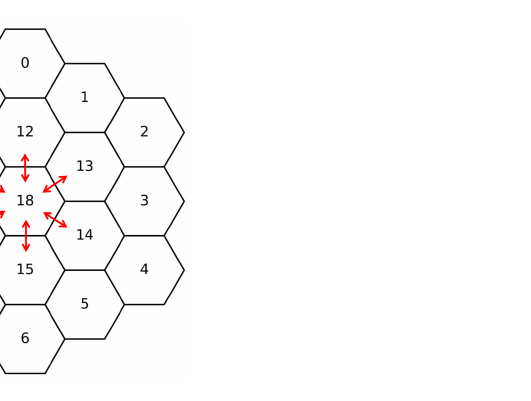
Figure 5. Communication task diagram of rank18 in a 3-ring 19-assembly core